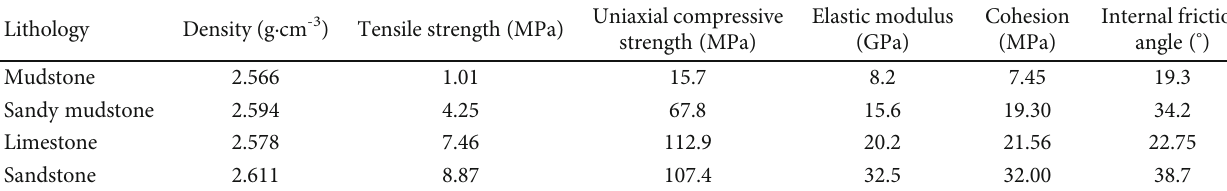
Table 1: Physicomechanical parameters of